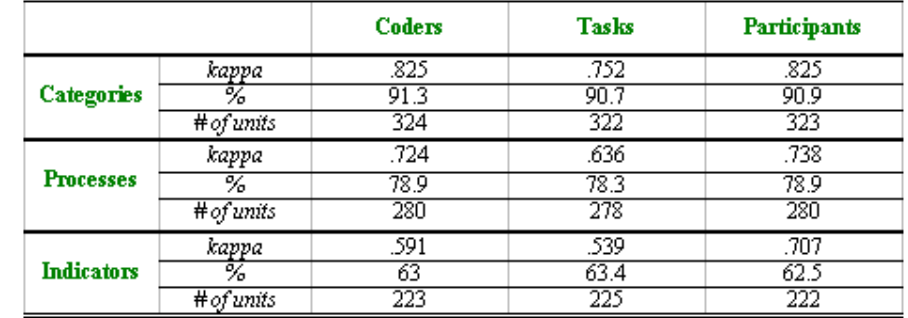
Table 1. Summary of Differences in Agreement